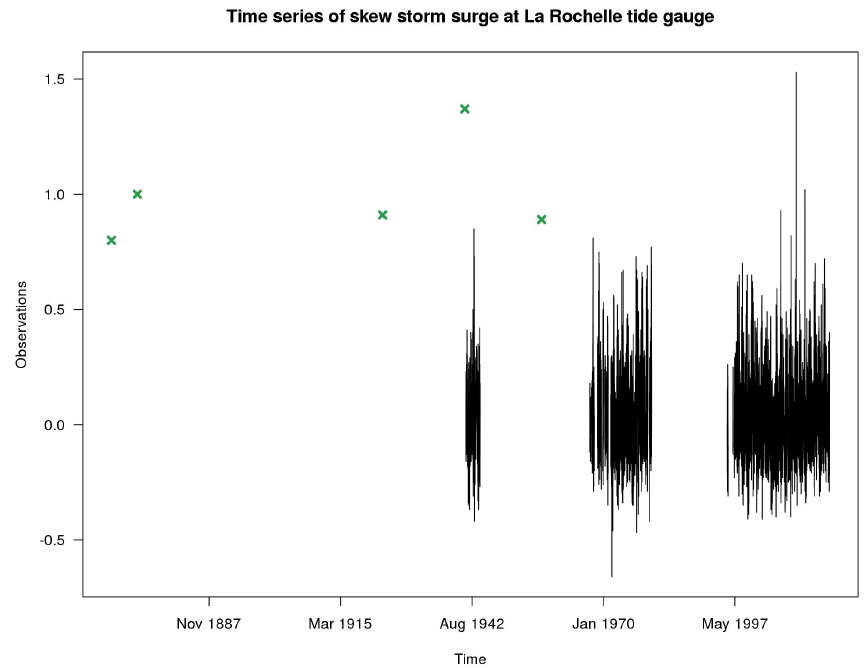
Figure 1. Illustrative example of the skew surge dataset at the La Rochelle tide gauge. In black the systematic skew surge and in green the historical isolated data points (non-systematic data) are